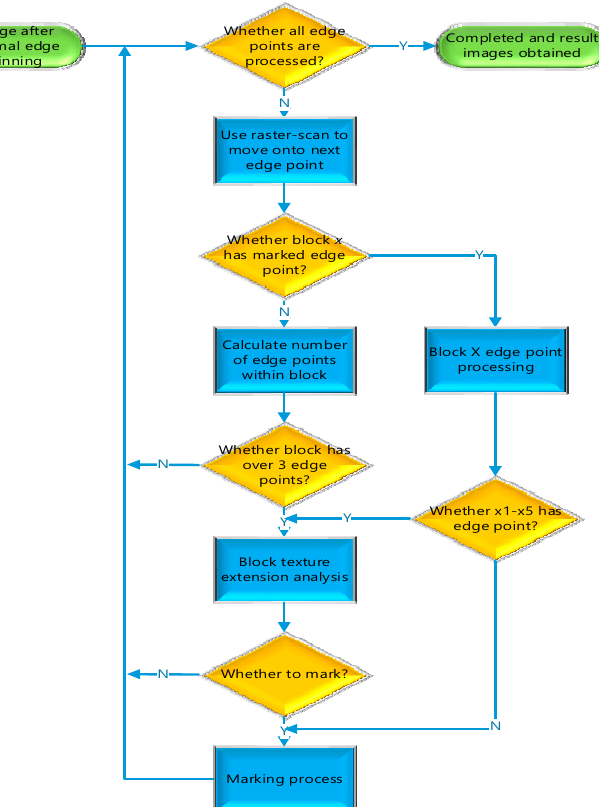
Figure 9. Edge texture construction process flowchart.